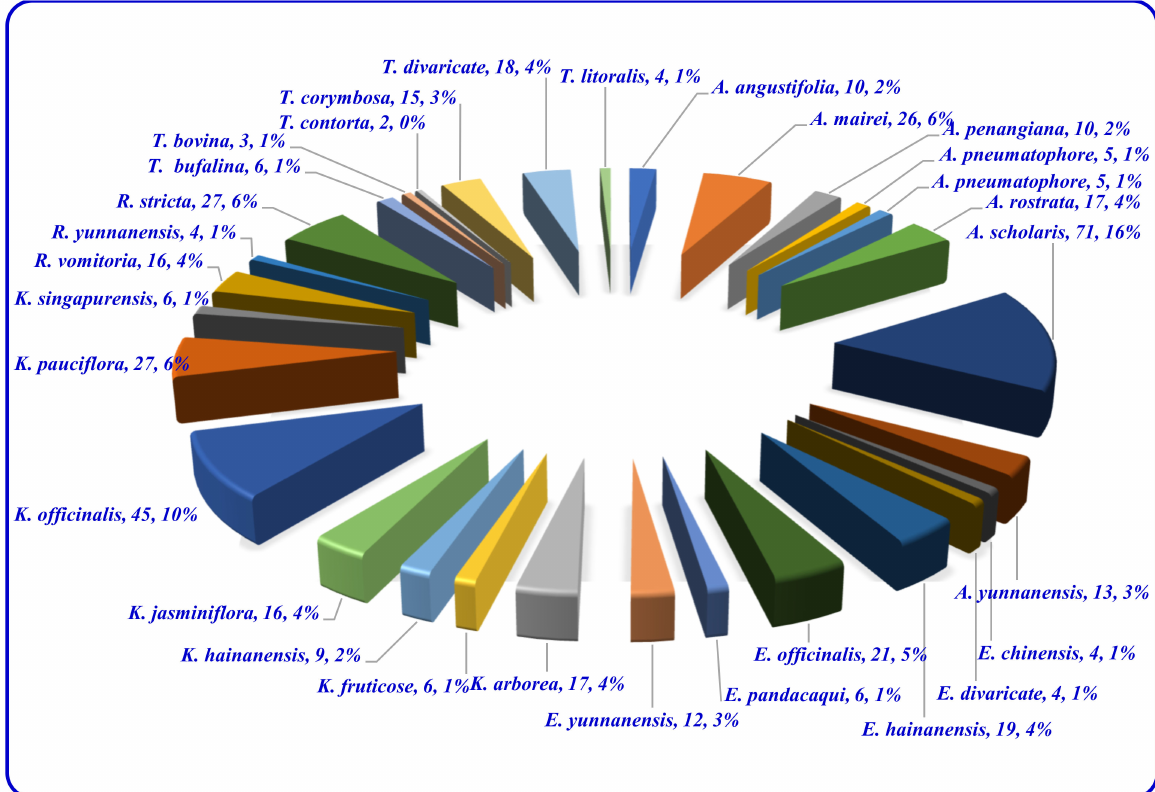
Figure 35. Percentage of reported compounds from the